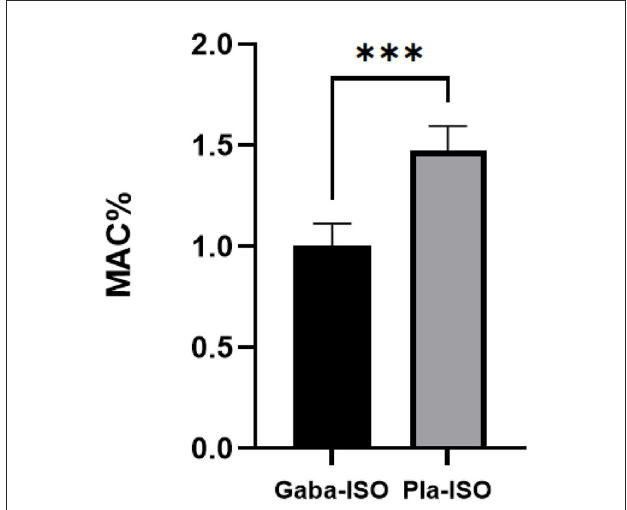
FIGURE2 Minimum alveolar concentration of isoflurane in the gabapentin and placebo treatments. Gaba-ISO, six cats were orally administered with 100mg gabapentin 2h before starting MAC determination and then maintained with isoflurane; Pla-ISO, six cats were orally administered with empty capsules 2h before starting MAC determination and then maintained with isoflurane. ***Significant difference between two treatments ( p <